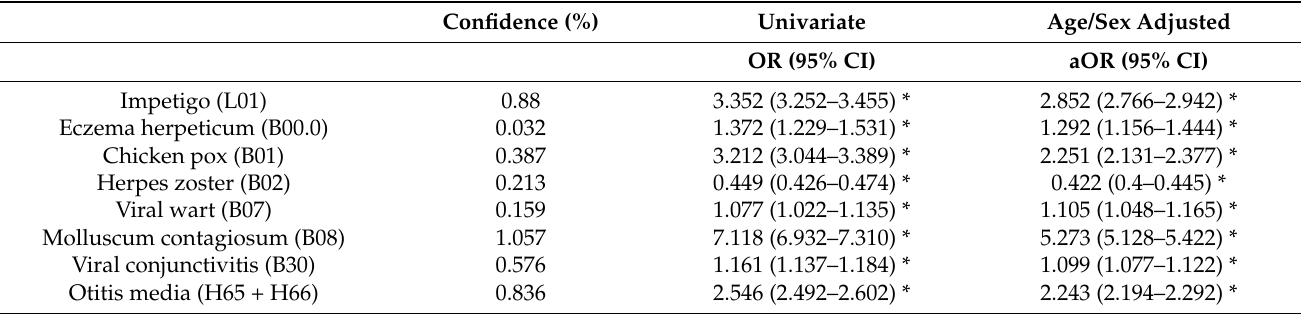
Table 2. Three-year risk and confidence of cutaneous infectious disorders in AD